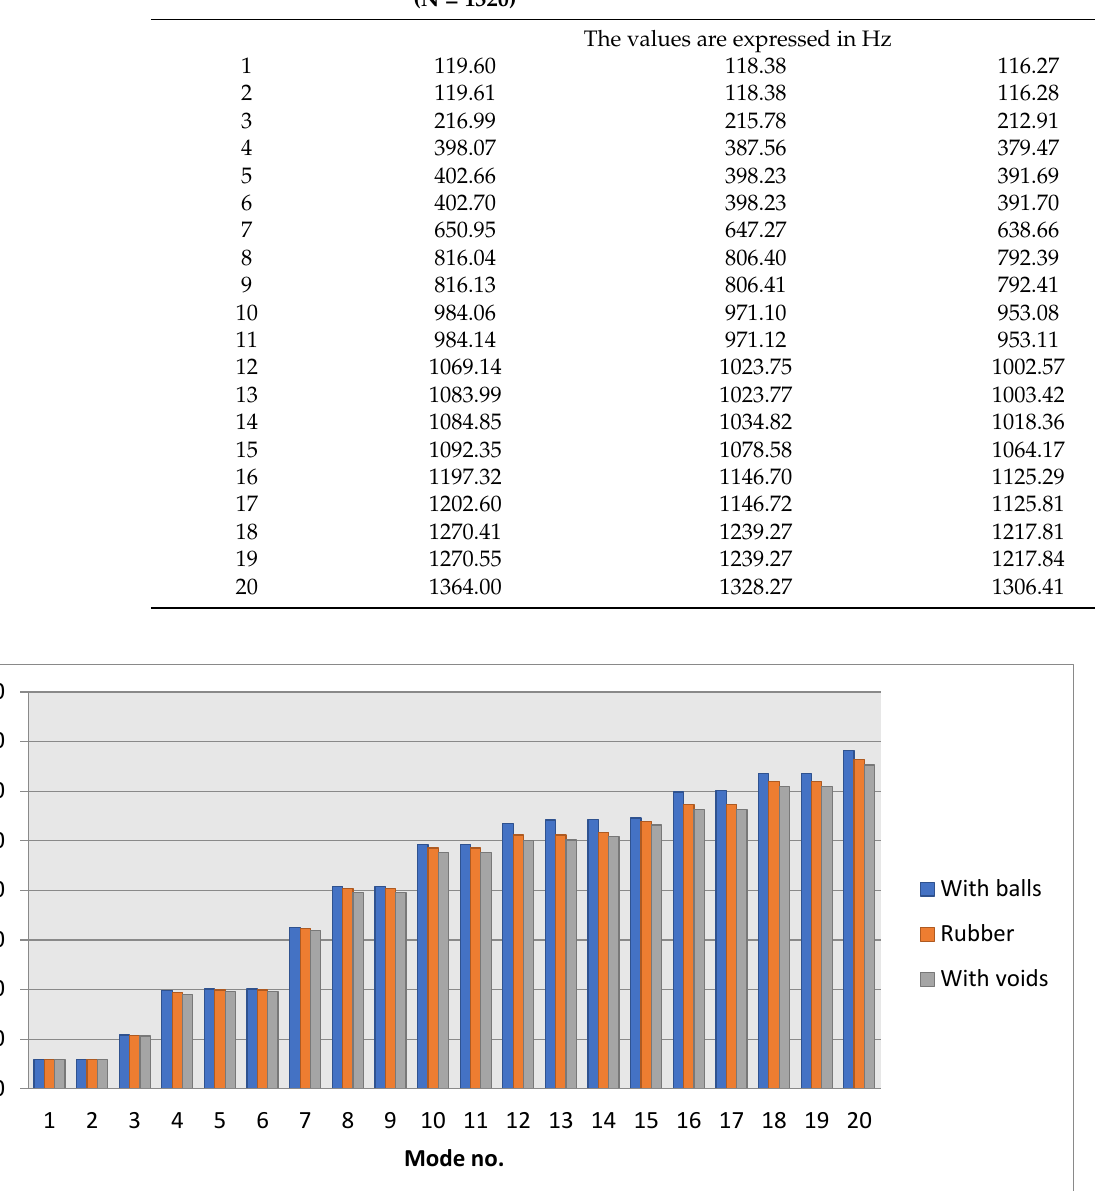
Table 4. The eigenpulsations for three different cases (N = 2040).